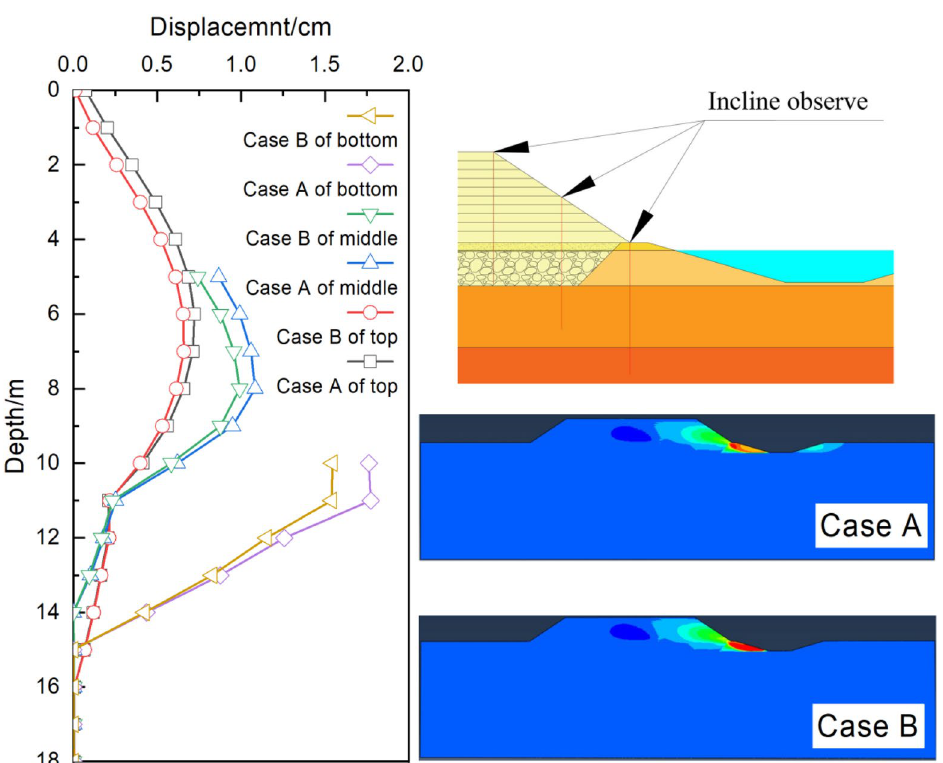
Figure 7. Comparison of the final slope